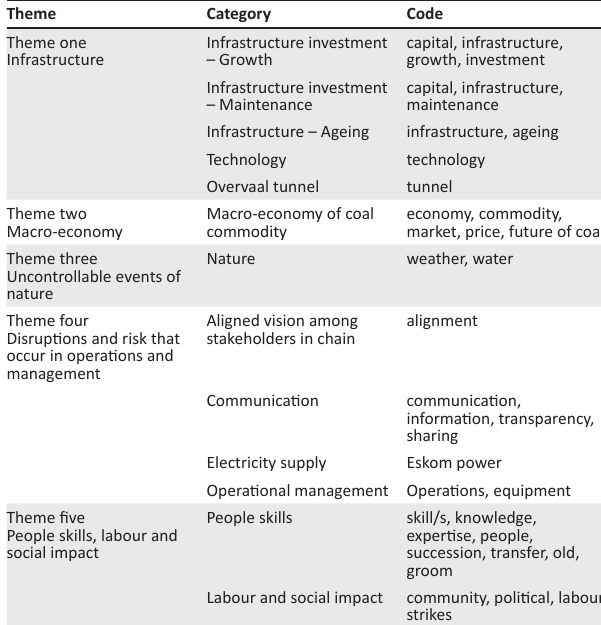
TABLE 2: Thematic map (themes, categories and